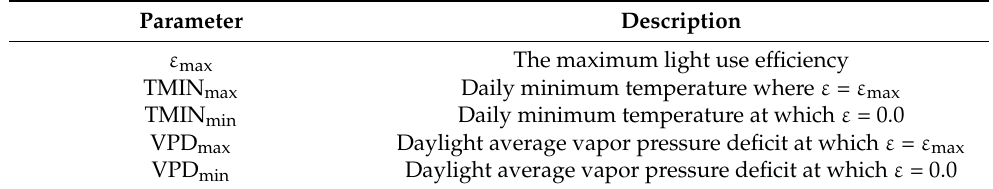
Table 2. Biome properties look-up table parameters for daily gross primary production (GPP) [50,74]. Parameter Description